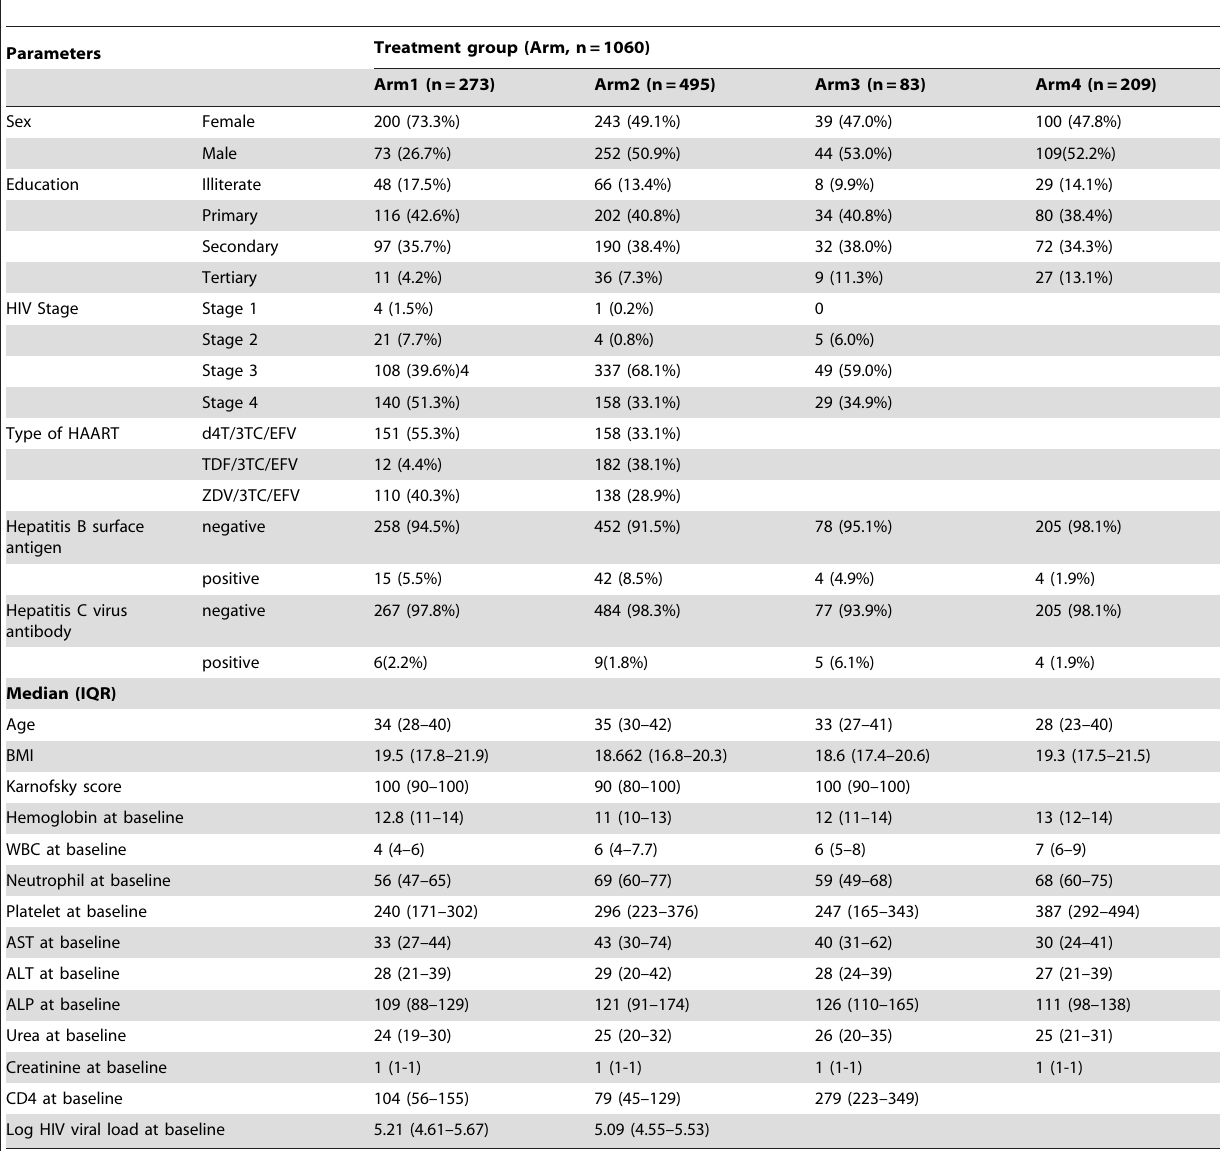
Table 1. Socio demographic, type of HAART, baseline clinical and laboratory characteristics of study participants stratified by treatment